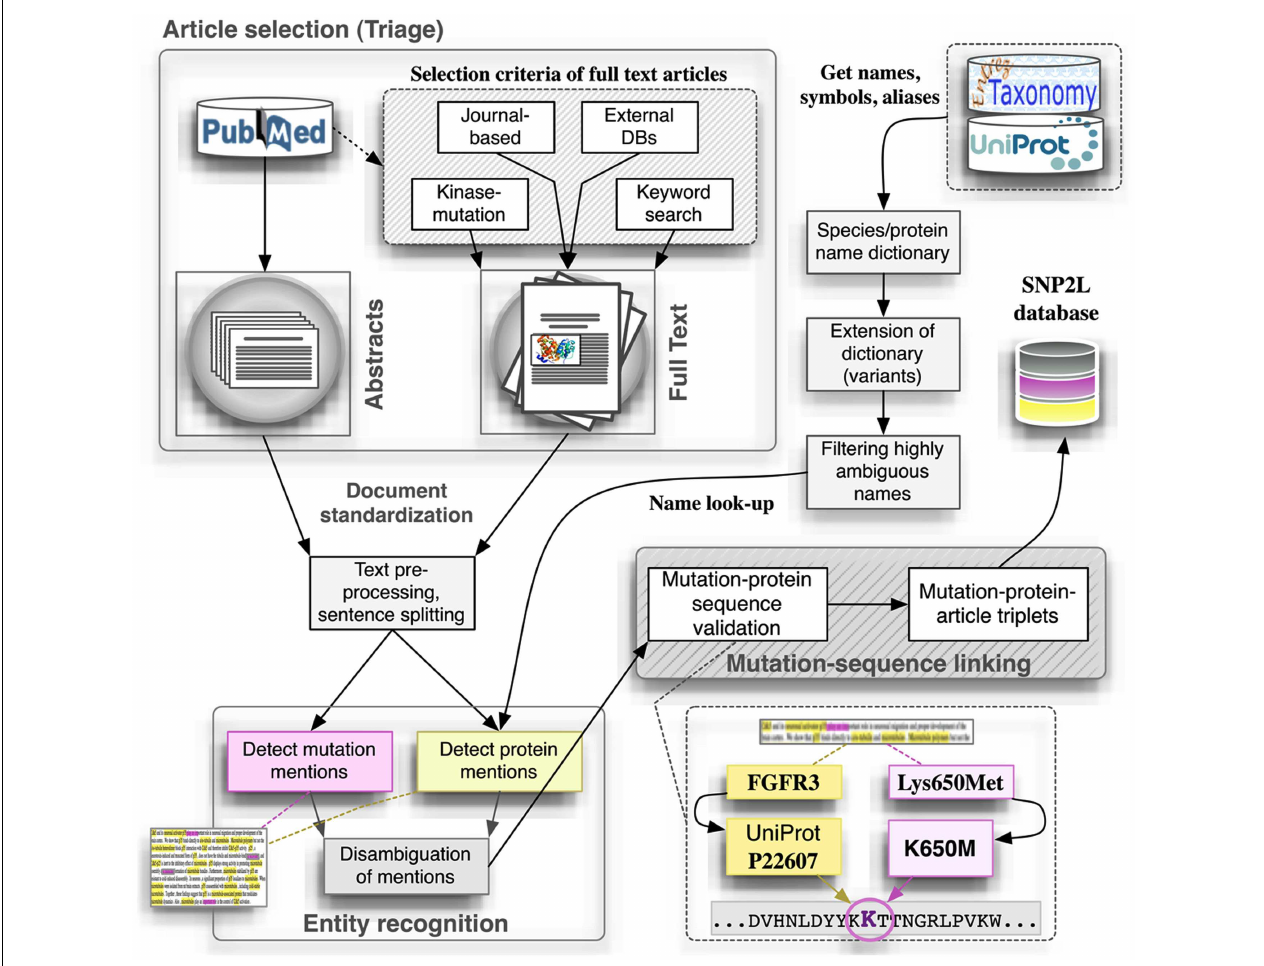
FIGURE 1 | SNP2L Pipeline as an example of a typical automatic method to extract mutation mentions from the literature. The pipeline integrates article retrieval, detection of mutations and proteins in the corresponding article, correct mutation-protein association and, finally, validation of the results.